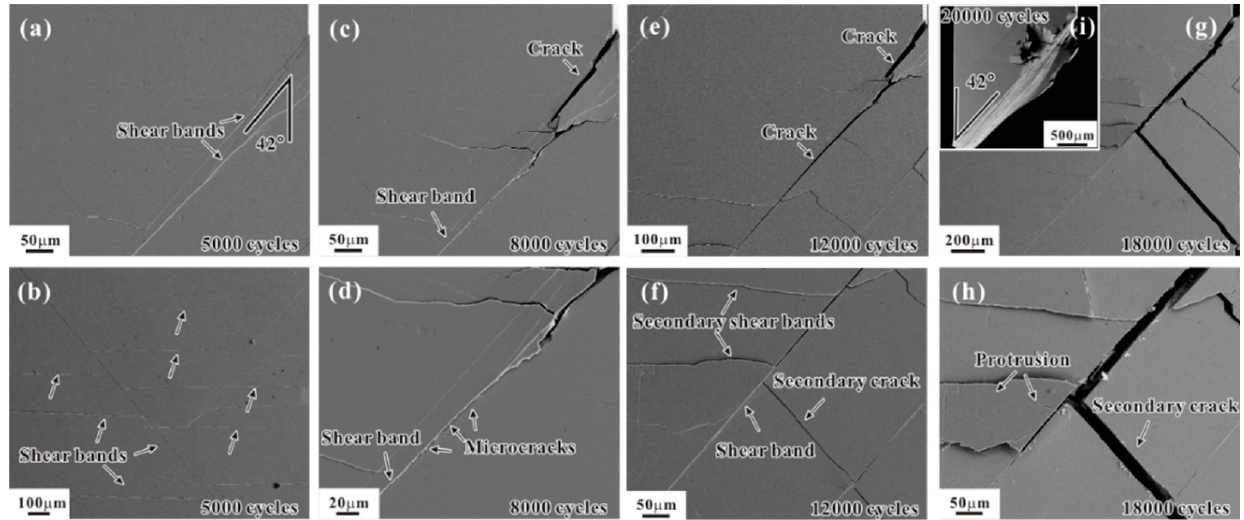
correspond well with the regions on the fatigue fracture surface, i.e., the crack propagation region, the fast fracture region and the smooth region.